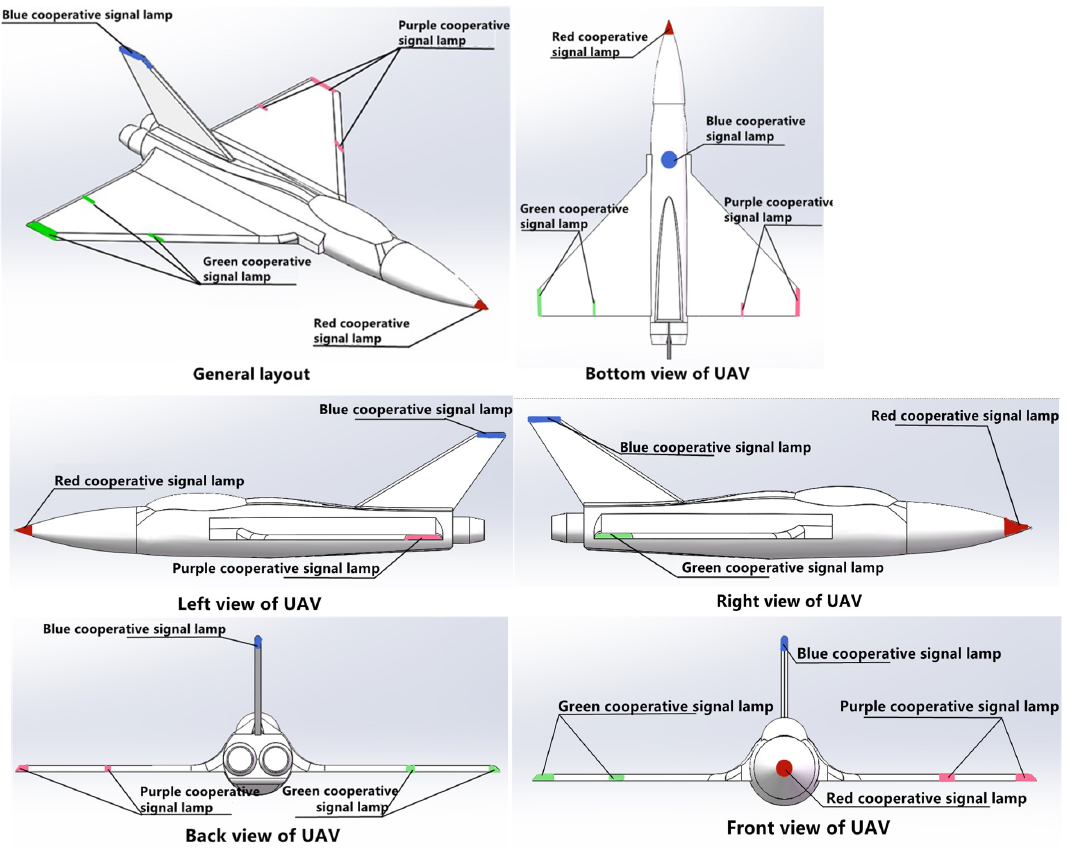
Figure 7. Distribution of the cooperative signal lamps located on the UAV surface in different